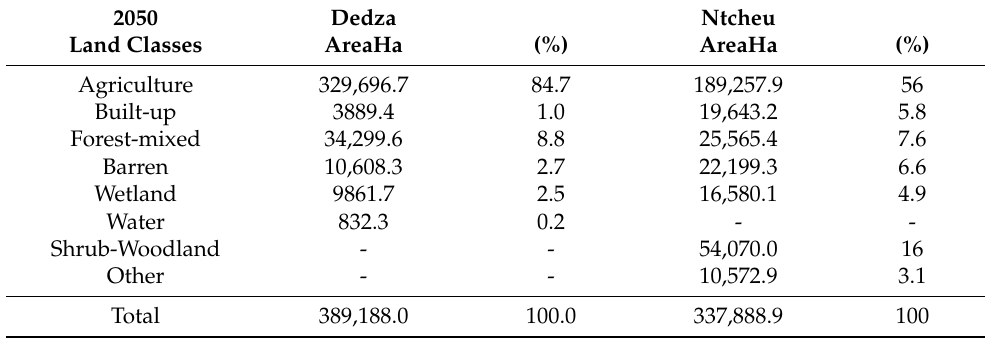
Figure 10. Projected Land Use and Cover—2050 for Dedza and Ntcheu Districts. Table 11. Area statistics of predicted land use land cover for 2050 (Area Ha = Area in